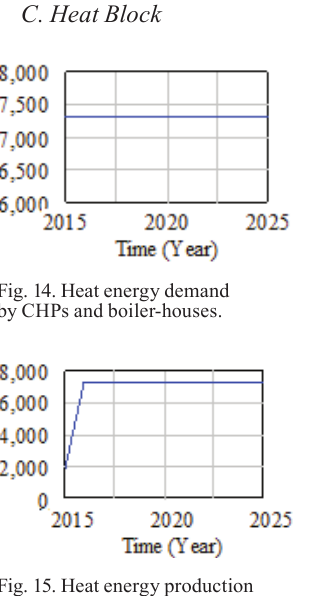
Fig. 20. Electricity consumption in the transport sector.